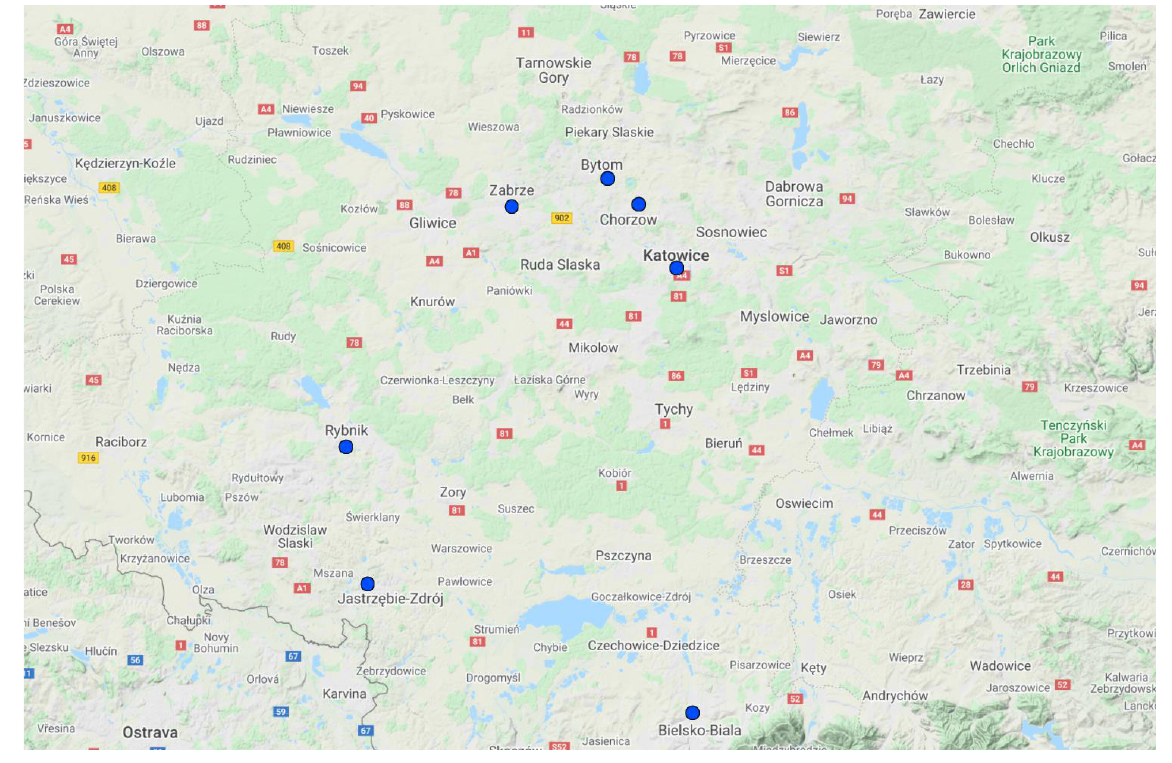
Figure 3. Cities located in the Silesian Voivodeship.